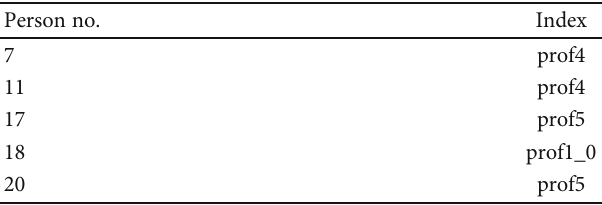
Table 10: The number of the respondents, in which index 2 indicated an arcade game di ff erent from the respondent ’ s opinion in the 1st place.